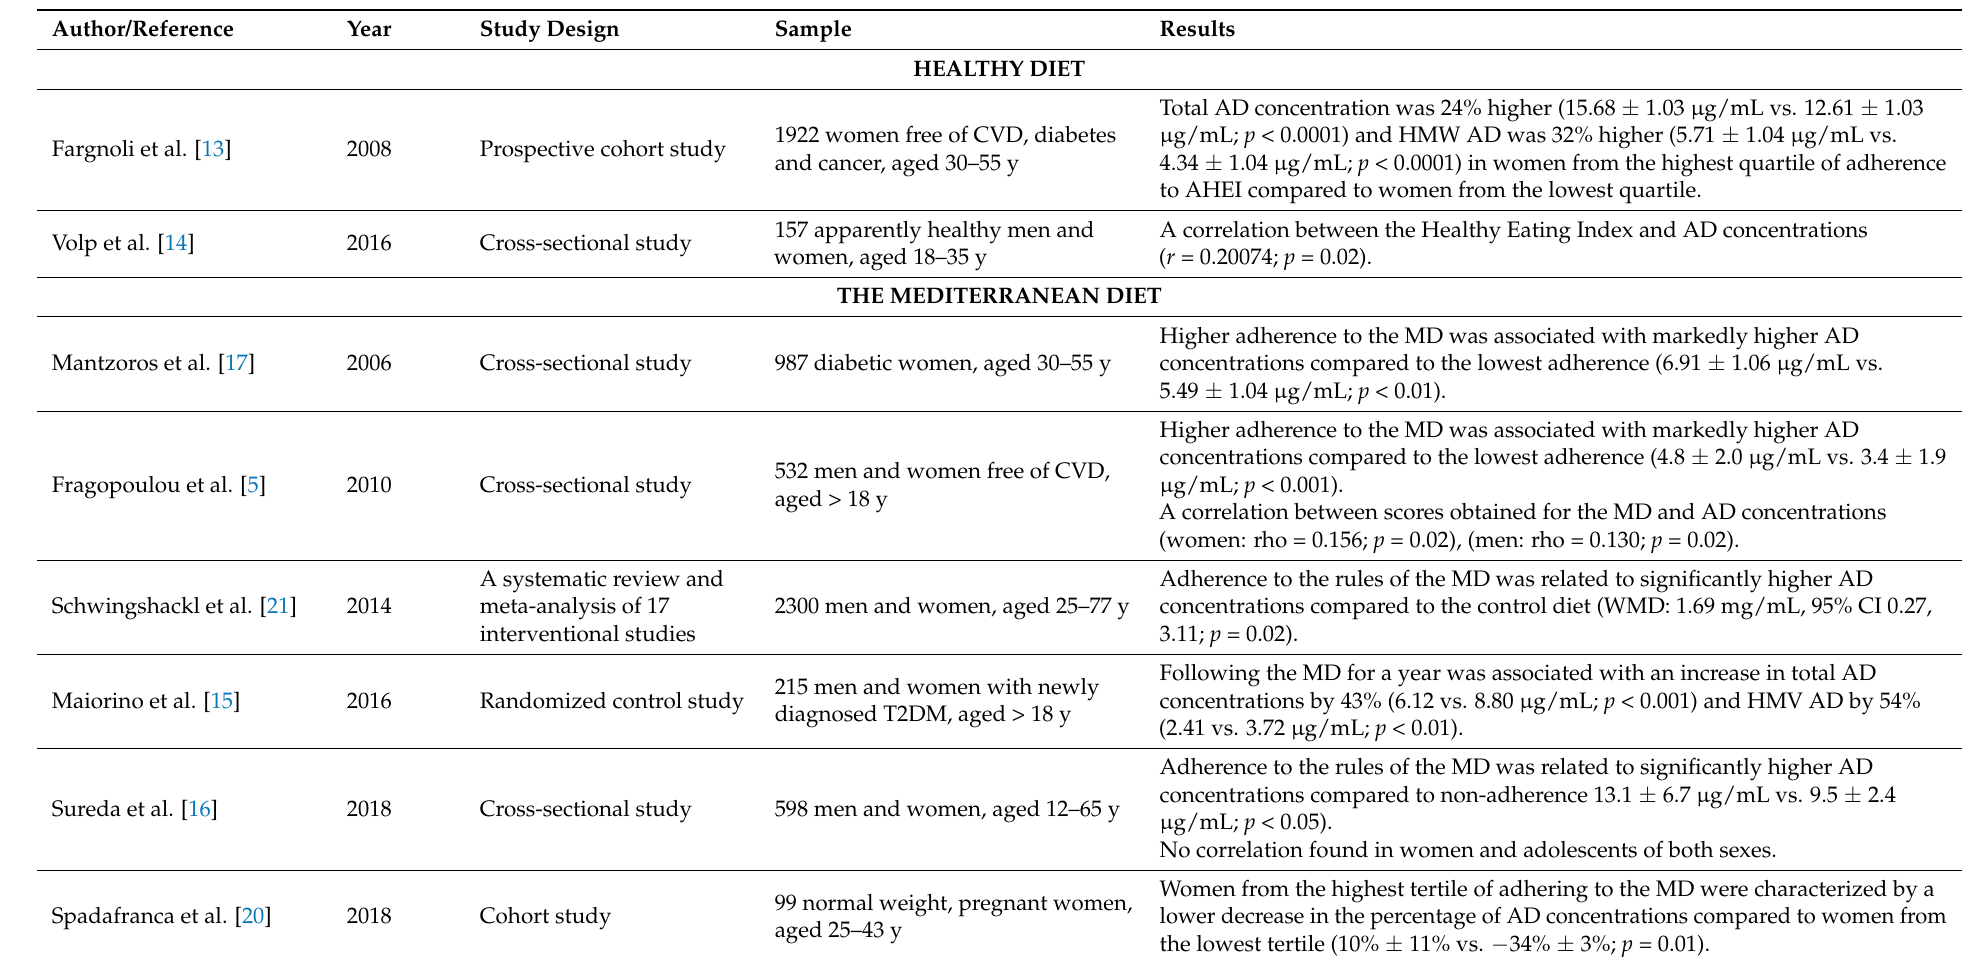
Table 1. Dietary patterns and the concentration of adiponectin (AD)—A positive